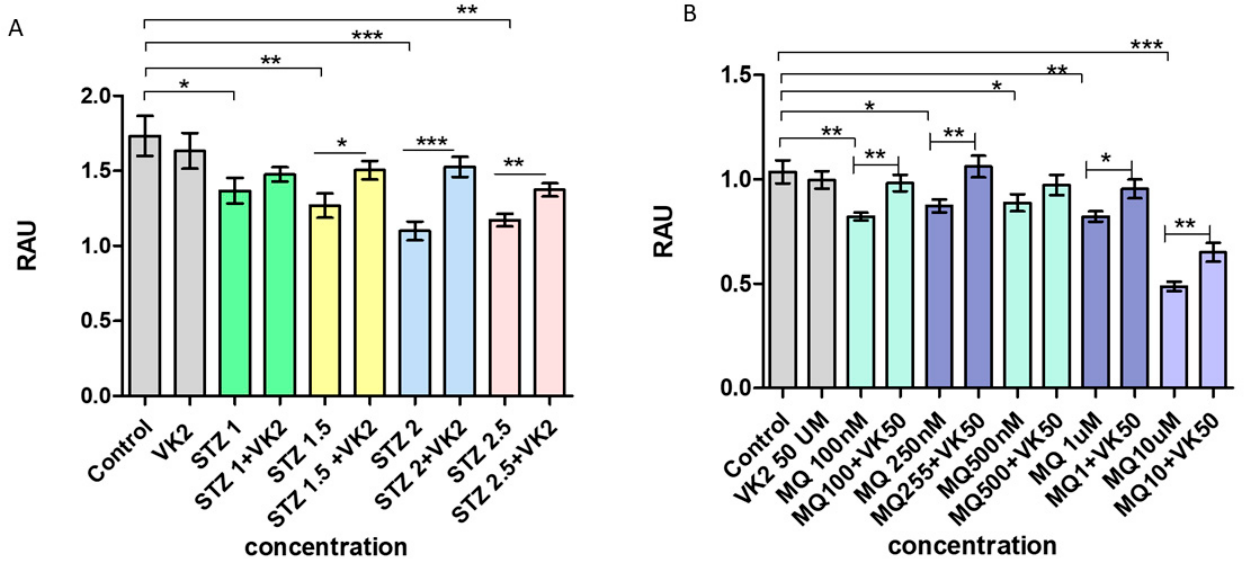
Figure 1. Measurement of cell viability in human SH-SY5Y neuroblastoma cells after ( A ) streptozotocin treatment and post-treatment with vitamin K2 (50 µ M) and ( B ) menadione treatment (MQ) and post-treatment with vitamin K2. The Y -axis represents the relative absorbance unit (RAU) at 550 nm and the X -axis represents the concentration of streptozotocin and menadione. The data are presented as mean ± SEM. Statistical analysis was performed using Student’s t -test and differences with p -values ≤ 0.05 were designated as significant. * p < 0.05, ** p < 0.01, and *** p < 0.001 denote significant differences compared to the control and between the treatment groups. (STZ—streptozotocin; VK2—vitamin K2; SV—post-treatment of streptozotocin (1–2.5 mM)-treated cells with vitamin K2 (50 µ M); MQ—menadione; MQ + VK2—post-treatment of menadione (100 nM–10 µ M)-treated cells with vitamin K2 (50 µ M).)